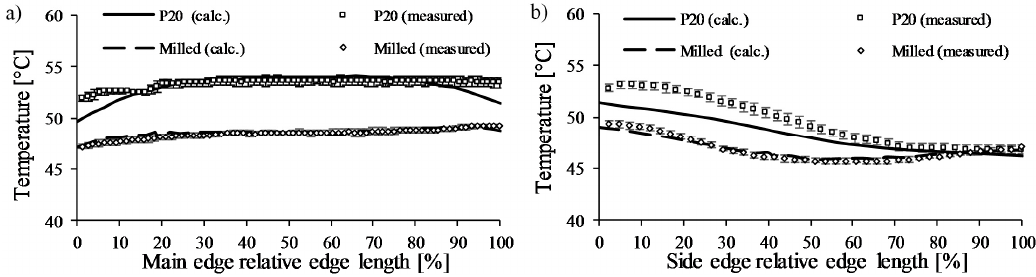
Figure 8. The temperature ramp of the Multi-part and P20 insert in the case of coolant temperature 42 ◦ C. Main edge ( a ); side edge ( b ).